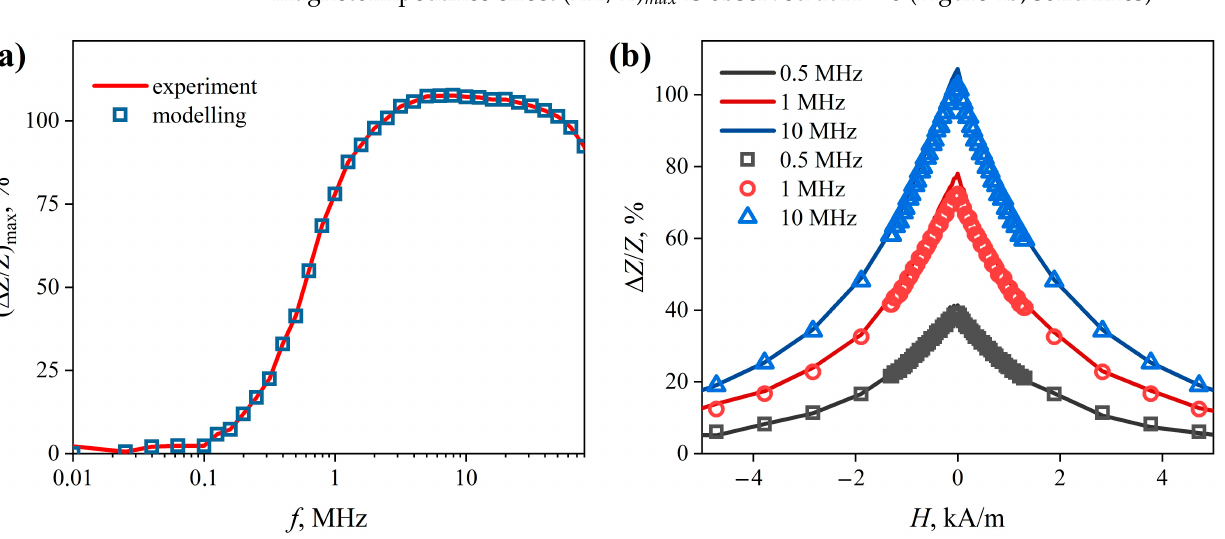
Figure 4. Dependence of the maximum MI value of the CuBe/FeCoNi composite wire on the AC frequency ( Δ Z / Z ) max ( f ) ( a ). Dependences of the MI of the CuBe/FeCoNi composite wire on the strength of the external magnetic field Δ Z / Z ( H ), obtained at AC frequencies of 0.5, 1, and 10 MHz ( b ). The lines correspond to the experimental dependences, the markers correspond to the values obtained as a result of modeling by the finite element method.